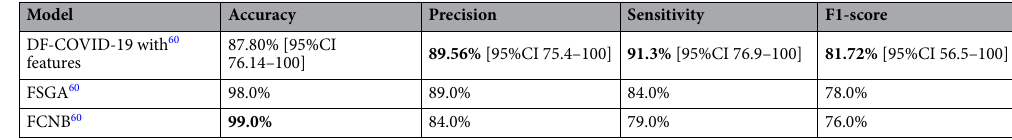
Table 4. The comparison results between DF-COVID-19, FSGA and